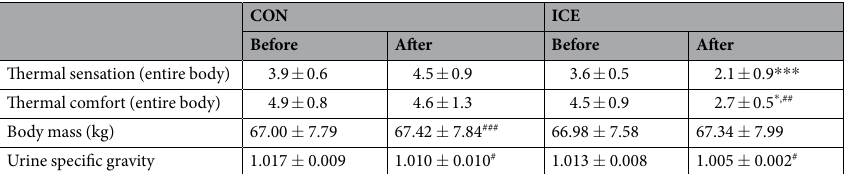
Table 1. Perception of thermal state and hydration state before and after the experiment. Values are expressed as mean ± standard deviation. CON, thermoneutral beverage; ICE, ice slurry beverage. Significantly different than CON: * p < 0.05; *** p < 0.001. Significantly different than Before: # p < 0.05; ## p < 0.01; ### p <